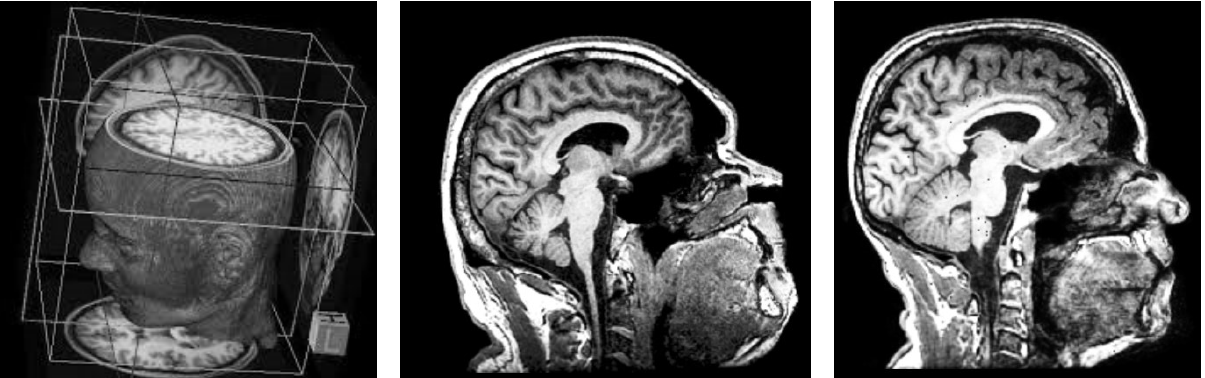
Figure 8: Initial preliminary results: (a) Fractal dimension (FD) analysis of MRI tomography provides 80% accuracy in diagnosing AD dis- ease: healthy brains (FD=3.51); AD brains (FD=3.3). These are very suggestive results from an extremely limited pool of data indicating